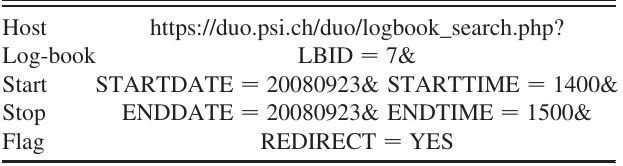
TABLE VII. Example URL to DUO logbook Web interface.